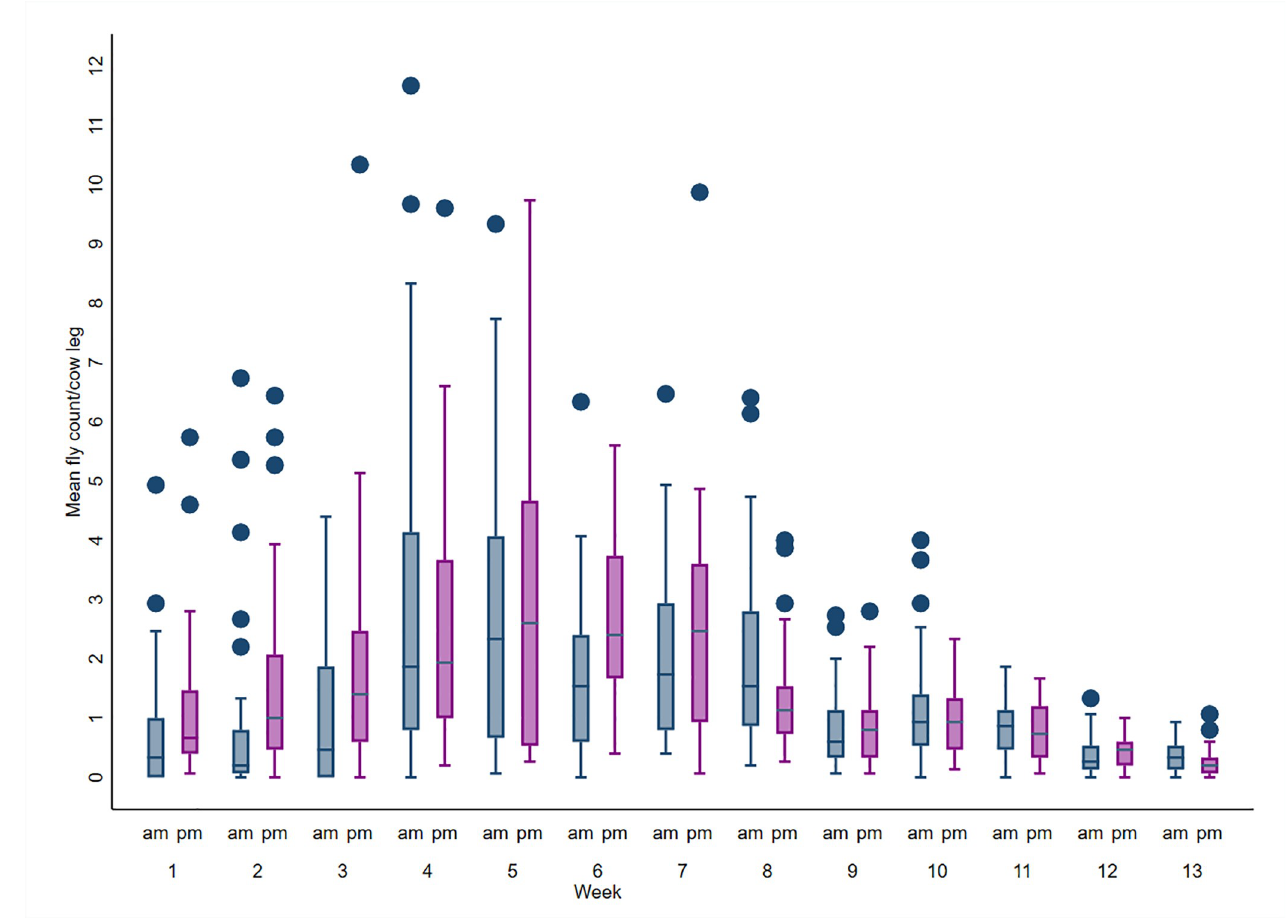
Fig 1. Boxplot of the mean weekly leg counts observed during morning (AM) and afternoon (PM) on the 10 study dairies over 13 weeks from May 1st to July 31st, 2017. The upper and lower horizontal lines of the box represent the 25 th and 75 th percentiles respectively, the horizontal midline represents the median, the upper and lower horizontal whiskers lines are the upper and lower limits, and the dots are the outliers.